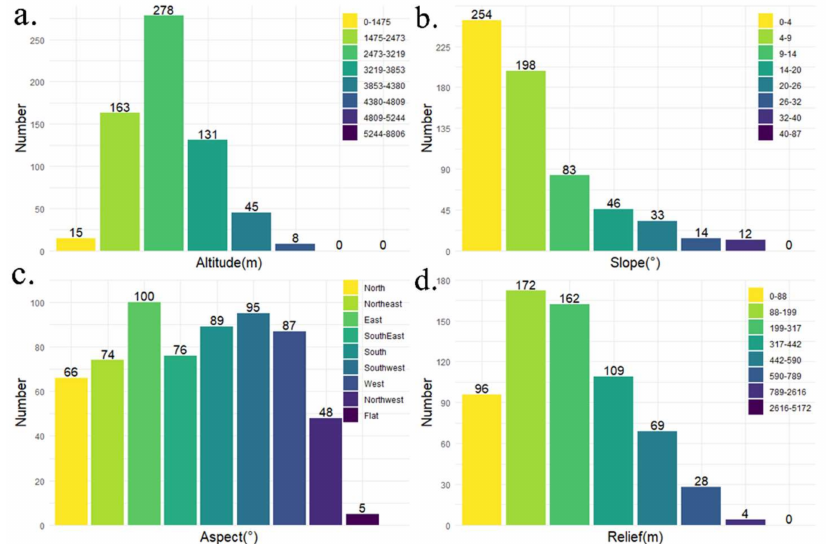
Figure 7. Statistics of RT villages in different topographic conditions: ( a ) altitude; ( b ) slope; ( c ) aspect; ( d )